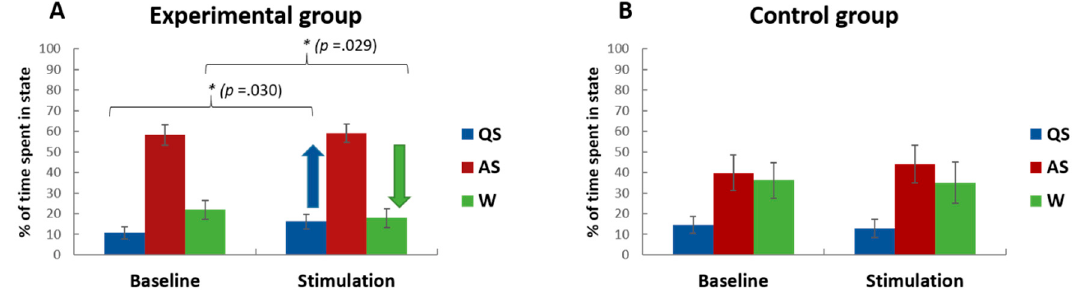
Figure 2. Behavioral states in response to auditory stimulation in infants prenatally exposed to (experimental group, EG) and unexposed to (control group, CG) auditory stimulation. Figures show the proportions of time spent in quiet sleep (QS), active sleep (AS), and wake (W) states during (4 × 3 min) baseline (silence) and during (4 × 3 min) auditory stimulation conditions in infants who were prenatally exposed to auditory stimulation ( A ; EG; n = 23) and who were not exposed ( B ; CG; n = 11). Note that infants familiar to prenatal stimulation (EG; A ) fell asleep more likely (less W) as well as slept deeper (more QS) during auditory stimulation and generally exhibited less W states at baseline and stimulation. On the other hand, unexposed infants (CG, B ) exhibit a pattern indicating no changes in behavioral states from baseline to stimulation. Curly brackets highlight the significant post-hoc t-test comparisons. * = statistical significance p < 0.05; Error bars refers to ± 1 Standard Error of the Mean (SEM).